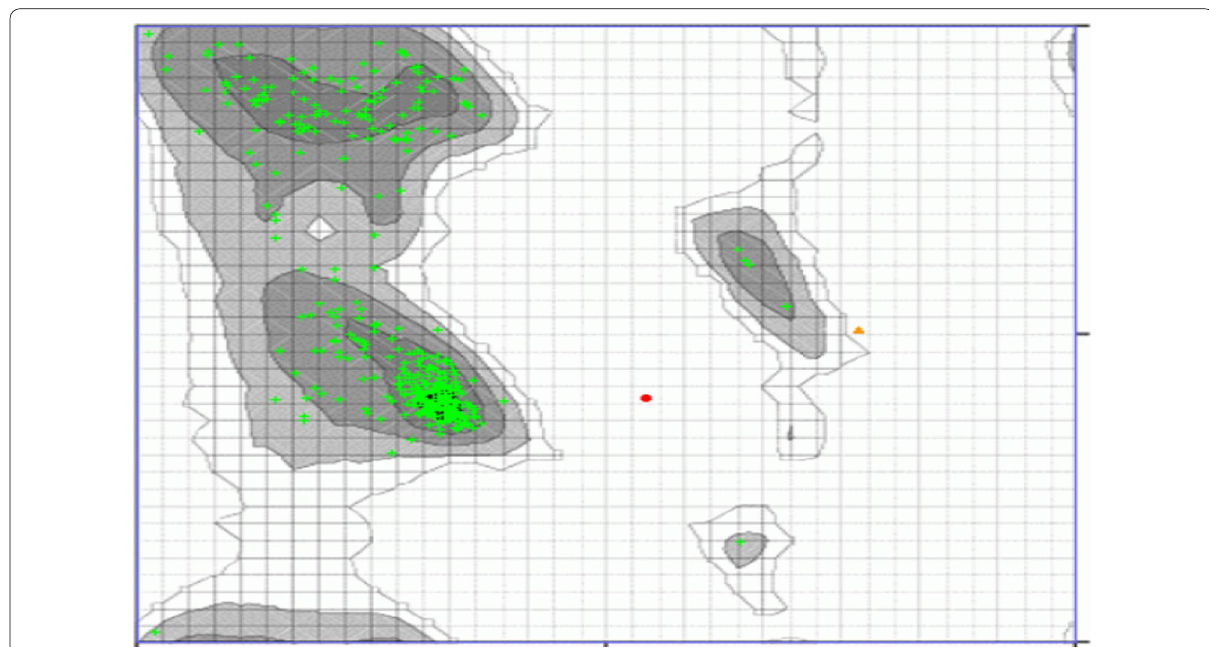
Fig. 6 G. mellonella GPx protein structure by Ramachandran plot with 99% of amino acids (https:// zlab. umass med. edu/)